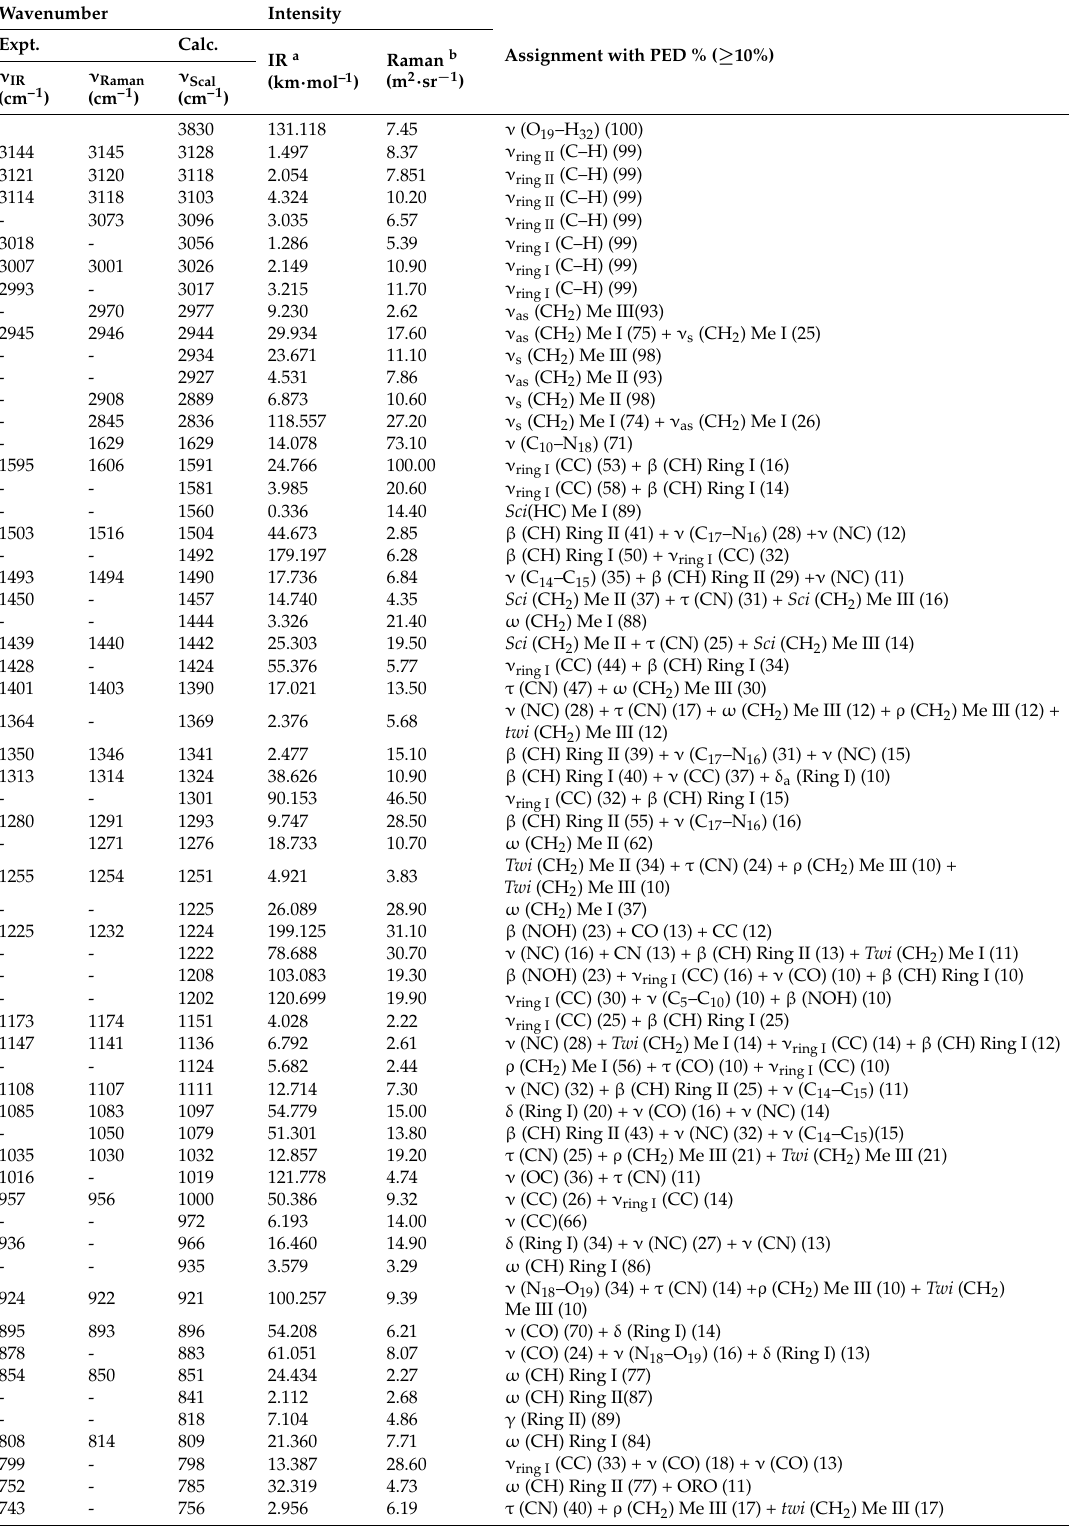
Table 4. Calculated vibrational wavenumbers, observed FT-IR and FT-Raman frequencies, FT-IR and FT-Raman intensities and their assignments with PED % for compound 4 .